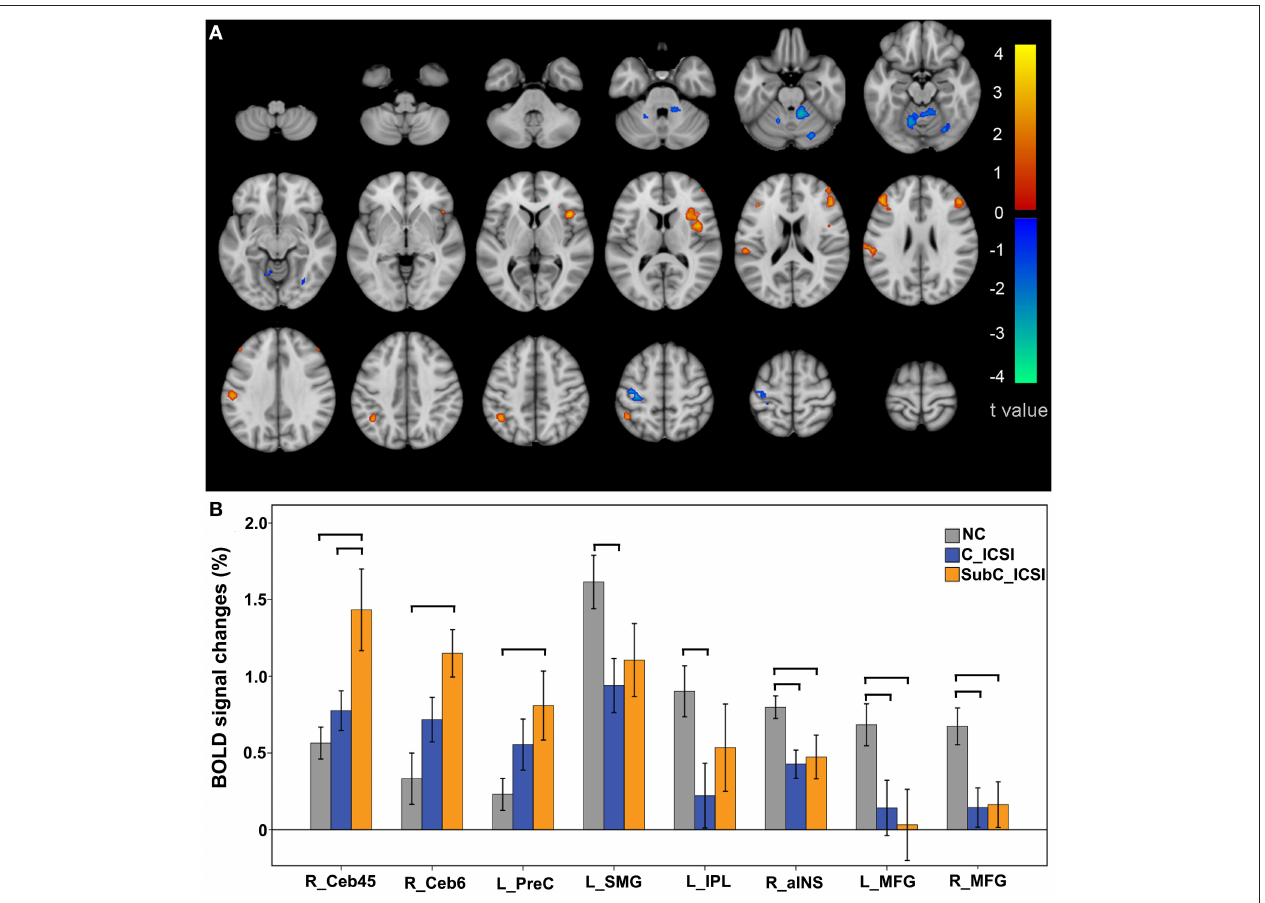
FIGURE 5 | Intergroup activation differences between the ISCI subjects and NC subjects in the ME task. Compared to the NC, the ISCI subjects showed increased activation in the left PreCG and right CB and decreased activation in the left SMG, left IPL, right aINS, and bilateral MFG (uncorrected, P <0.05 and cluster ≥ 30 , A ). Furthermore, the activation increment in the motor-related regions of the cervical ICSI subgroup was not significant compared to the NC subgroup, while the activation decrements in the cognitive-related regions in both the cervical and sub-cervical ISCI sub-groups was comparable to those of the NC subgroup (B) . ISCI, incomplete spinal cord injury; NC, normal controls; ME, motor execution; PreCG, precentral gyrus; CB, cerebellum; SMG, supra marginal gyrus; IPL, inferior parietal lobule; aINS, anterior insula; MFG, middle frontal gyrus. The horizontal bar represents a statistically significant difference between the two